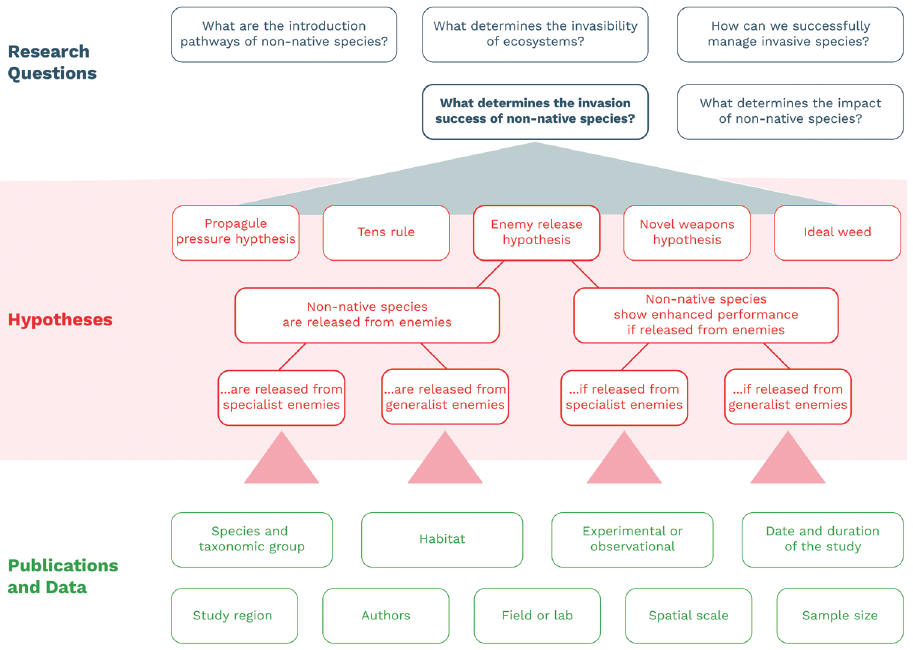
Figure 1. Proposed hierarchical structure of enKORE that will allow for an interactive and zoomable vis- ualization of invasion science. enKORE will allow users to structure research done in biological invasions according to: (a) focal research questions (examples shown on top of the figure), (b) hypotheses addressing (some of) these questions (examples shown for one research question, see Enders et al. 2018, 2019, 2020 for details about these hypotheses) which can be further divided into sub-hypotheses (shown for the en- emy release hypothesis, cf. Heger and Jeschke 2014, Jeschke and Heger 2018) and (c) other features of the publications and data. enKORE’s hierarchical structure will allow users to zoom from research questions into hypotheses, sub-hypotheses, publications and data, or vice versa to zoom out from publications and data to the hypotheses and research questions these